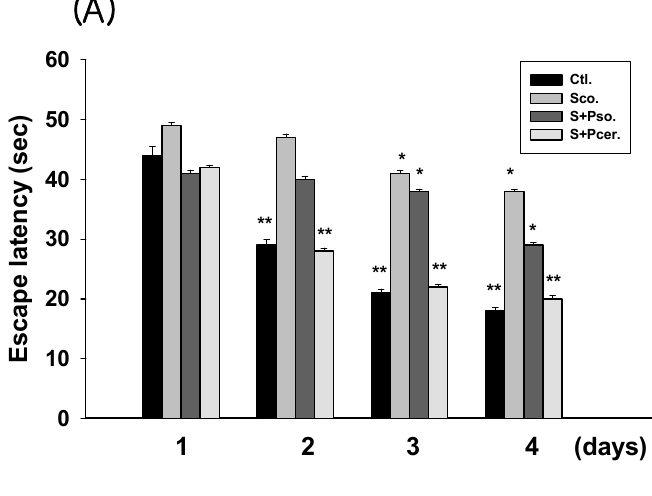
Figure 4. Effects of PSO and PCER on the escape latencies in the training trial sessions and on the swimming time in the probe trial session of the Morris water maze task in scopolamine-induced memory deficit mice. PSO, PCER (50 mg/kg) or vehicle (saline) was orally administered to mice at 60 min before training trial session. Memory impairment was induced by scopolamine (1 mg/kg) intraperitoneal treatment. Eight different animals were used per each treatment group. The training trial and the probe trial sessions were performed as described in Materials and Methods. Data represent the mean ± standard error (SE). # p < 0.05 in comparison with control, * p < 0.05 in comparison with treated